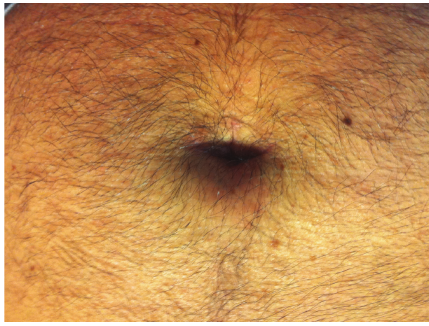
Figure 3: Transumbilical incision one month after surgery.